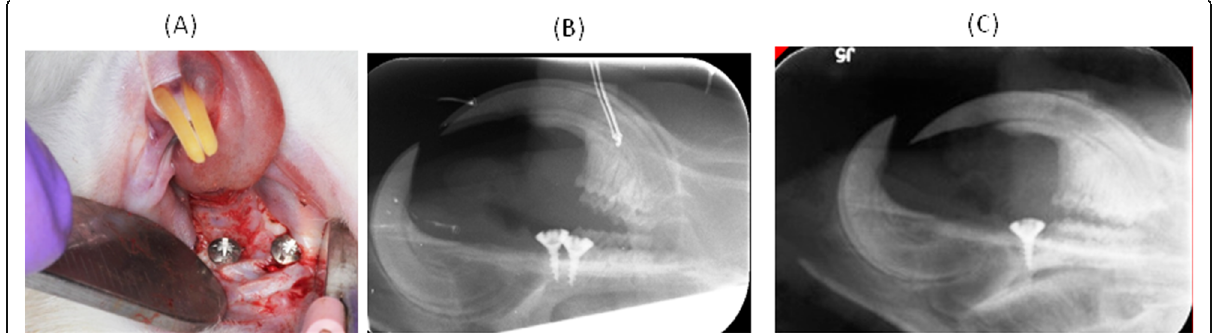
Fig. 2 Implantation of two implants at maxillary diastemata per rat. a Surgery implantation. b X-ray periapical picture after surgery. c Seven weeks after